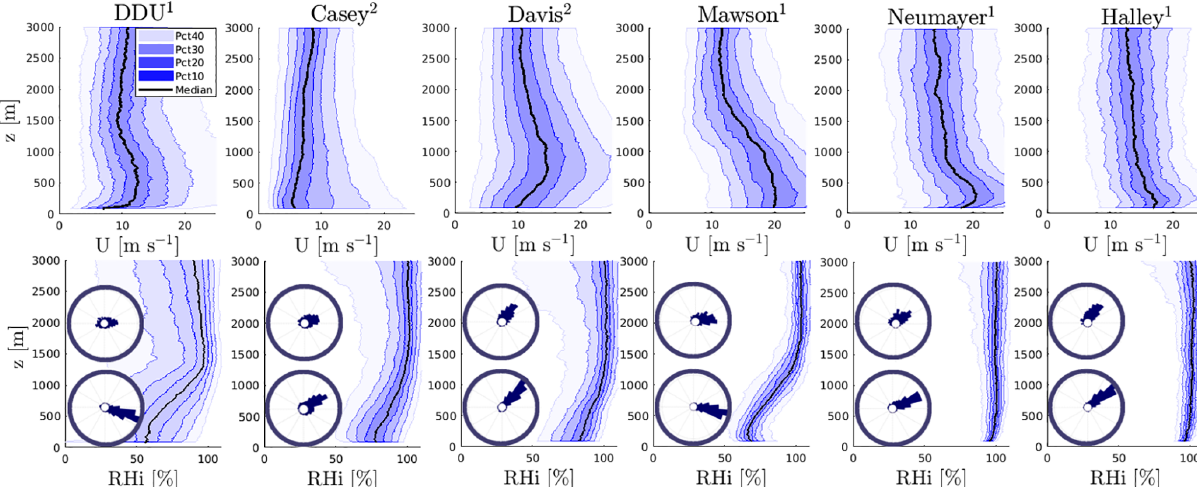
Figure 4. Vertical profiles of the wind speed (top row) and relative humidity with respect to ice (bottom row) from radiosonde measurements at five Antarctic stations along the eastern Antarctic coast. Data sets are restricted to precipitation cases. Black lines are the medians, colored lines refer to the 10th, 20th, 30th, 40th, 60th, 70th, 80th and 90th percentiles. In the legend, “Pct x ” refers to the shaded area that covers x percent of the data greater than the median and x percent of the data lower than it. The altitude z is above ground level. Wind roses (conditioned to precipitation events) at z = 500 and z = 2000m are plotted in the lower row panels. Numbers in exponential form next to station names indicate the number of radiosoundings per day at the corresponding